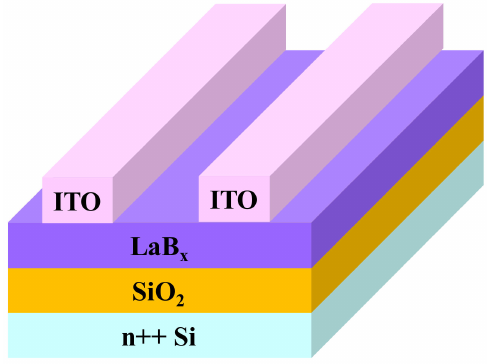
Figure 1. The schematic structure of LaB x -TFT.